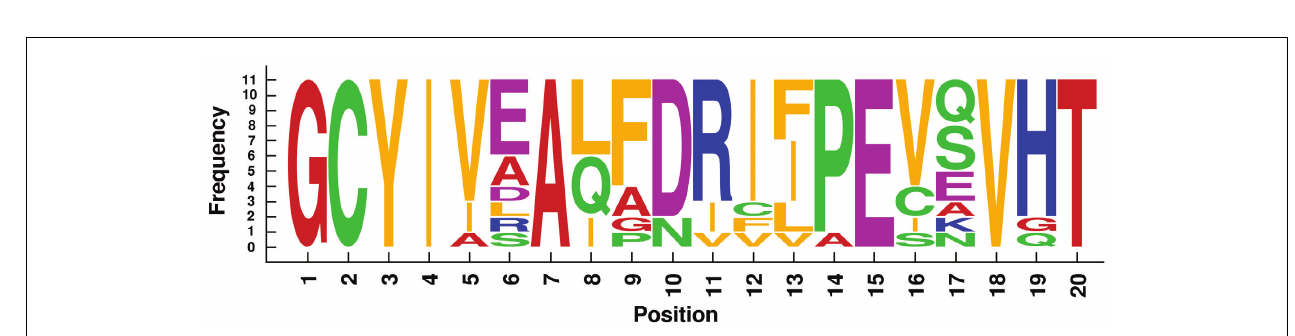
FIGURE 8 | Sequence logo of mapped residues in the best alignment of the 8 Plastocyanin proteins.